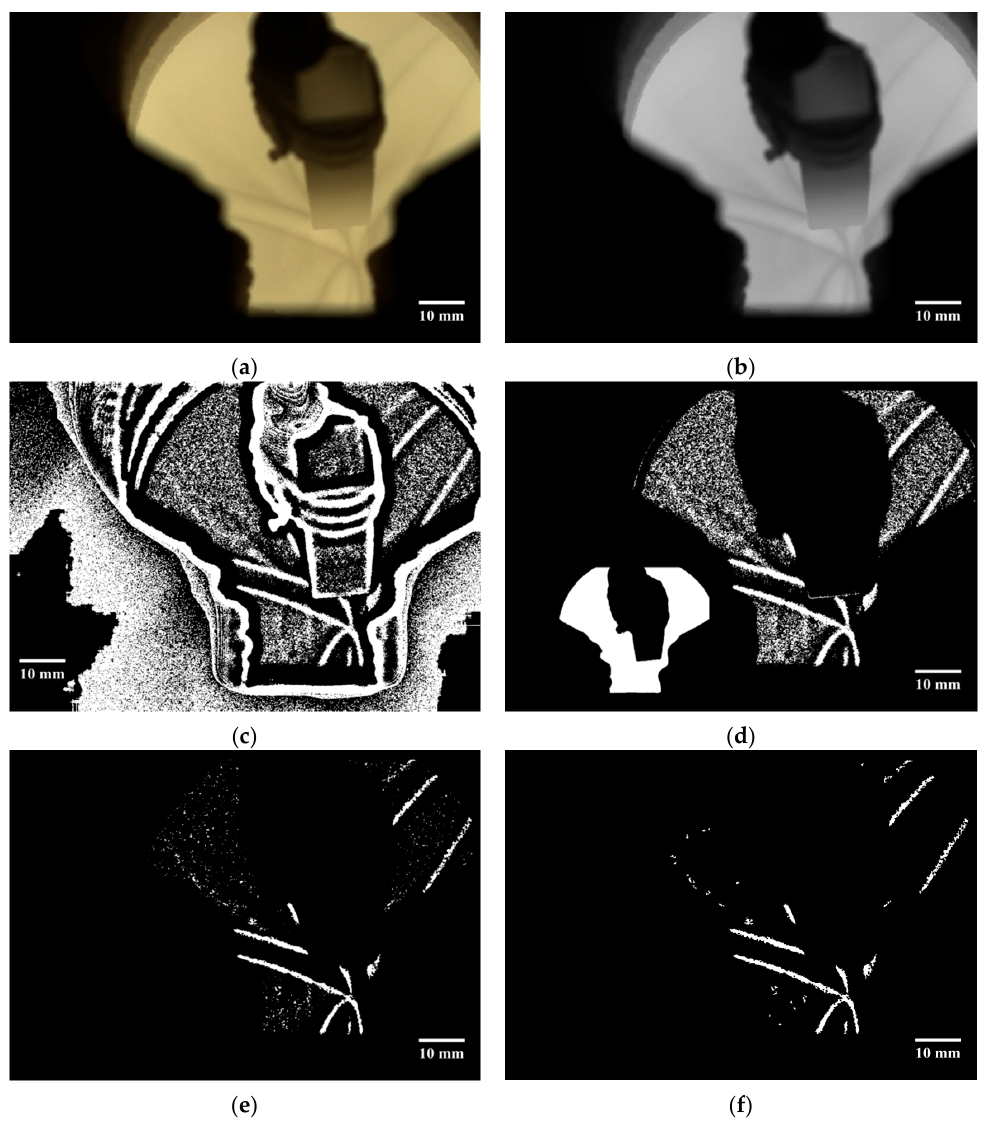
Figure 4. Image preprocessing procedure: ( a ) acquiring image information; ( b ) extracting brightness information; ( c ) the binarization process; ( d ) extracting the region of interest; ( e ) removal of noise elements; ( f ) result of image preprocessing.